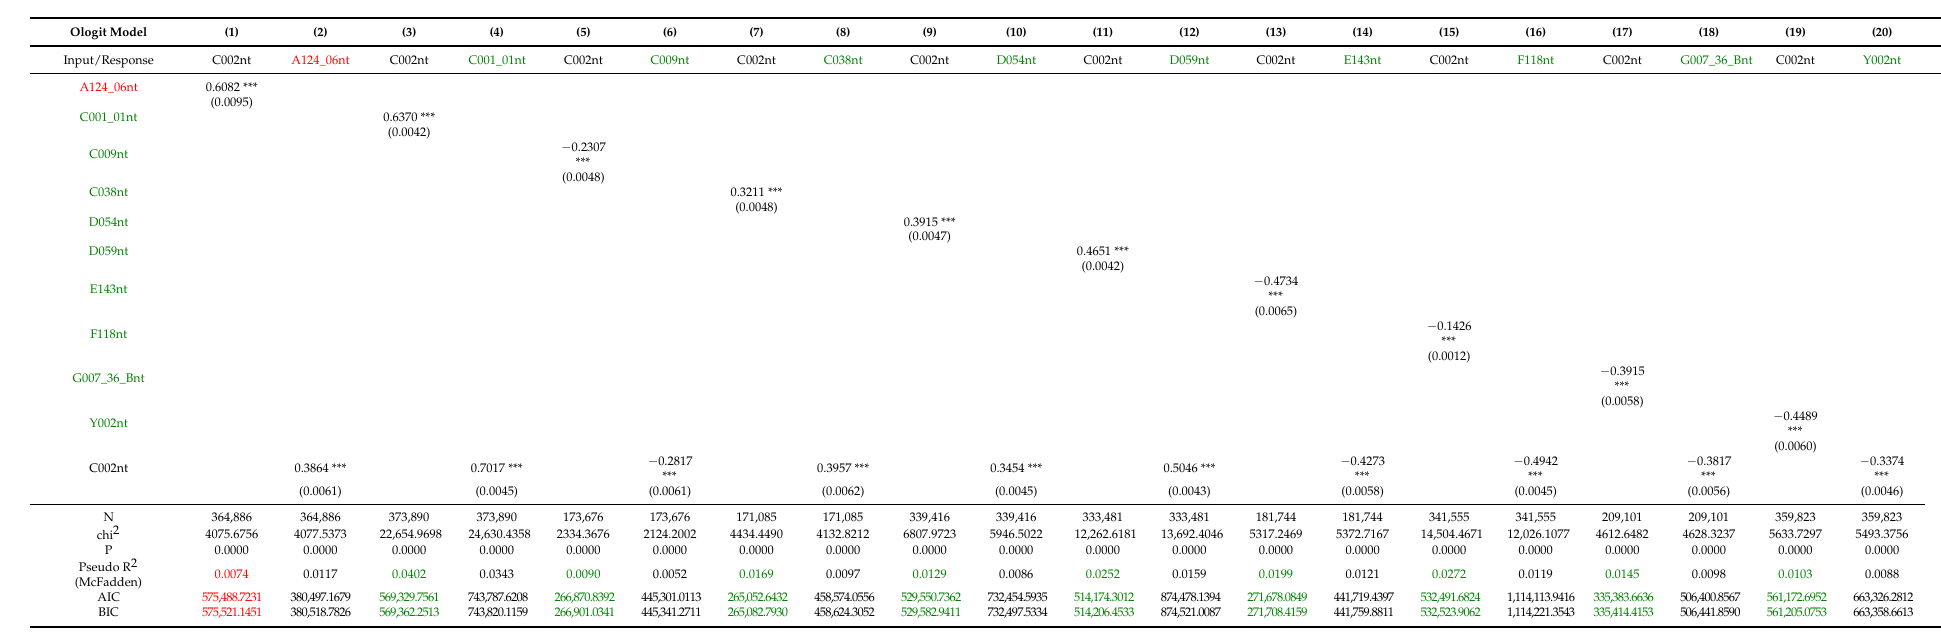
Table A4. The results of the first stage of reverse causality checks using ordered